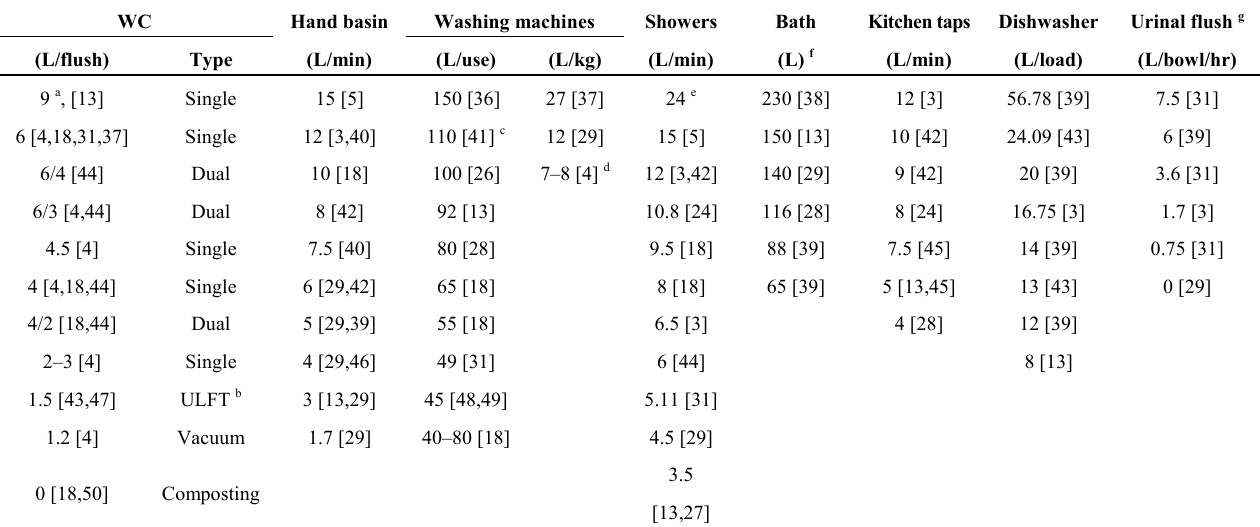
Table 3. Technologies: Range of water usage from existing and modern indoor technological appliances.